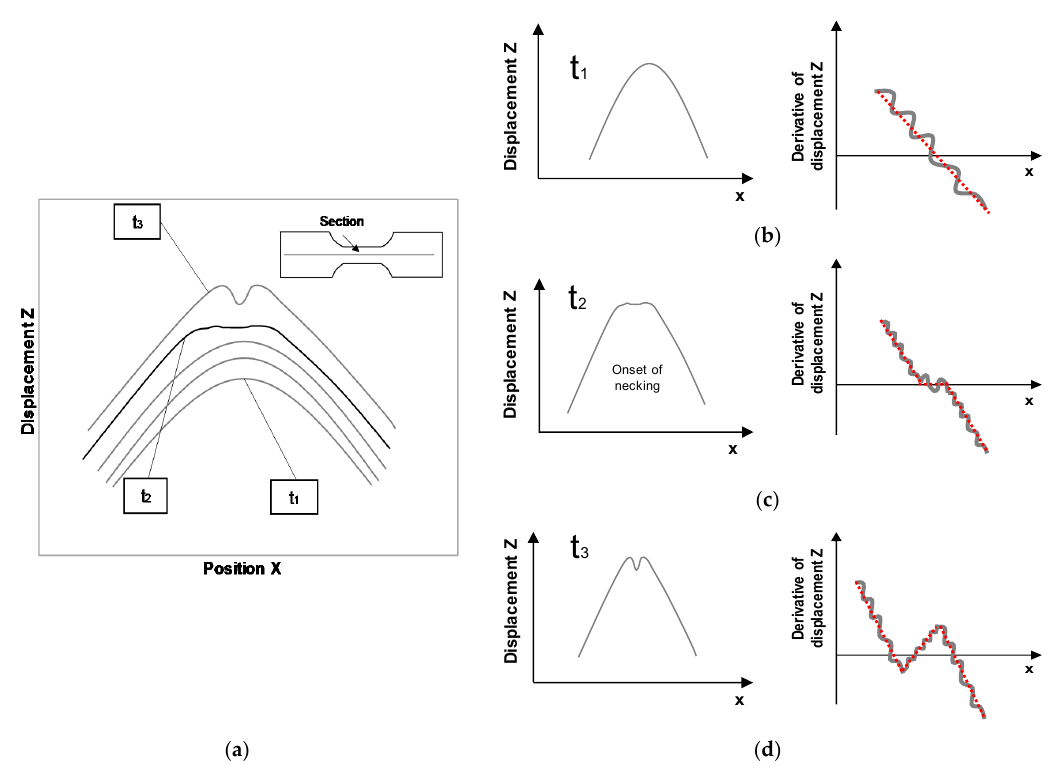
Figure 2. Schematic representation along a section perpendicular to the failure area of a Nakajima test. ( a ) Z-displacement over the X-position. Temporal evolution of the Z-displacement and its spatial derivative on a section perpendicular to the failure area at an instant: ( b ) Before necking, ( c ) onset of necking and ( d ) after necking. Adapted from Martínez-Donaire et al. [31].